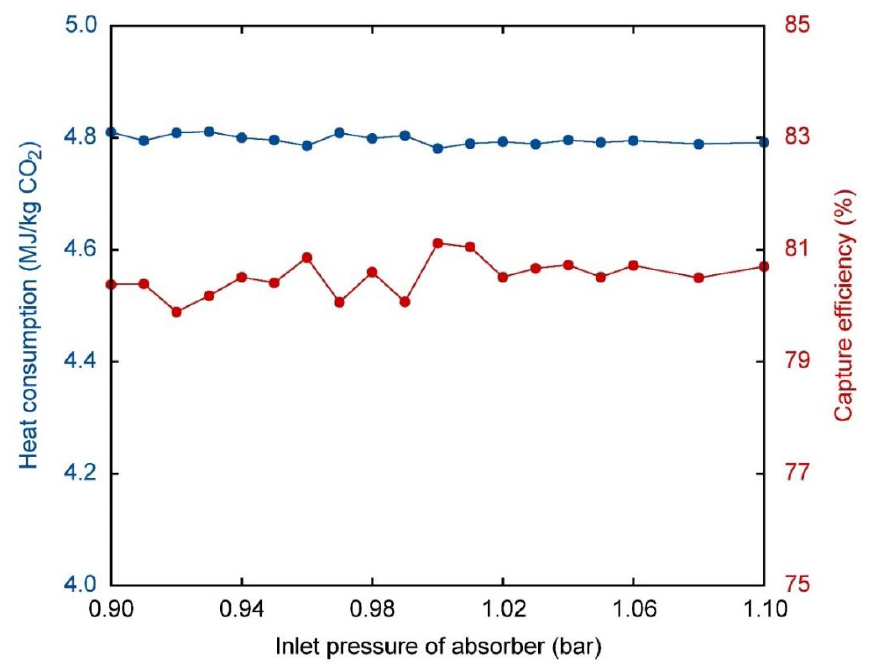
Figure 5. Variation of inlet pressure versus heat consumption and capture efficiency.